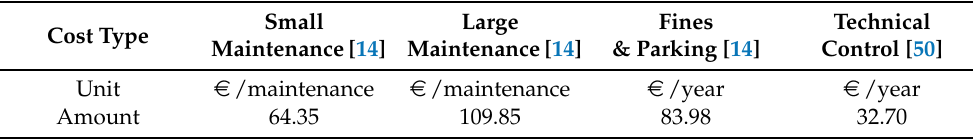
Table 8. Overview of non-EV specific costs